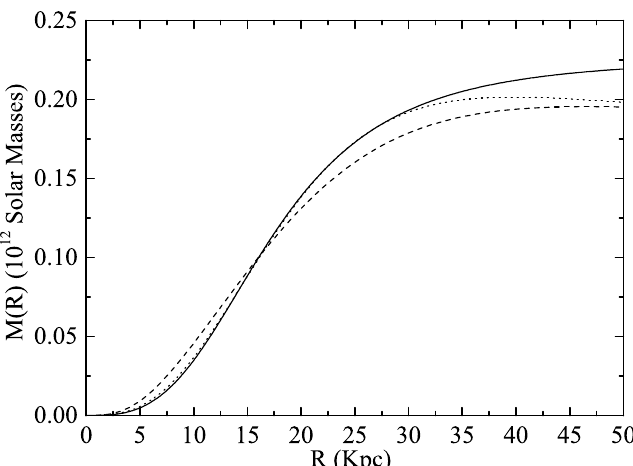
Figure 3. This figure is similar to Figure 2, but for the model in Equation (22). The parameters for the mass function of the apparent dark matter are: κ = 5, n = 2, and β = 20 Kpc (dashed line), and κ = 5, n = 3, and β = 15.8 Kpc (dotted